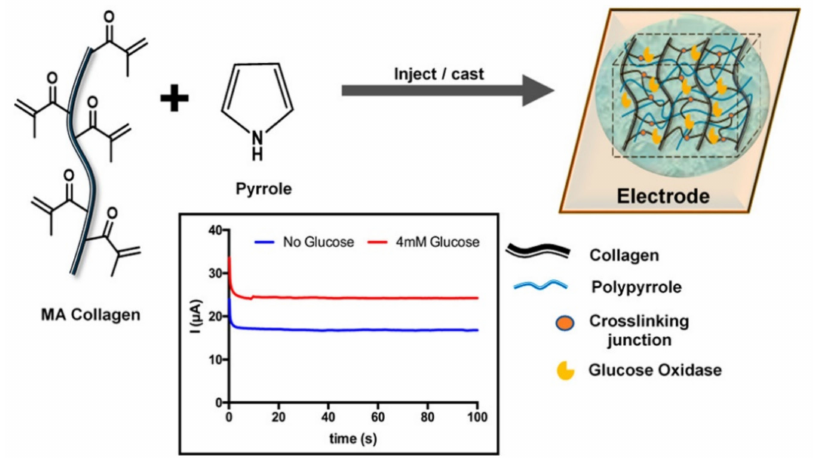
Figure 2. Methacrylated collagen hydrogel with polypyrrole and glucose oxidase for the detection of glucose in vitro and in tissues. Reprinted with permission from reference [80]. Copyright 2018 American Chemical